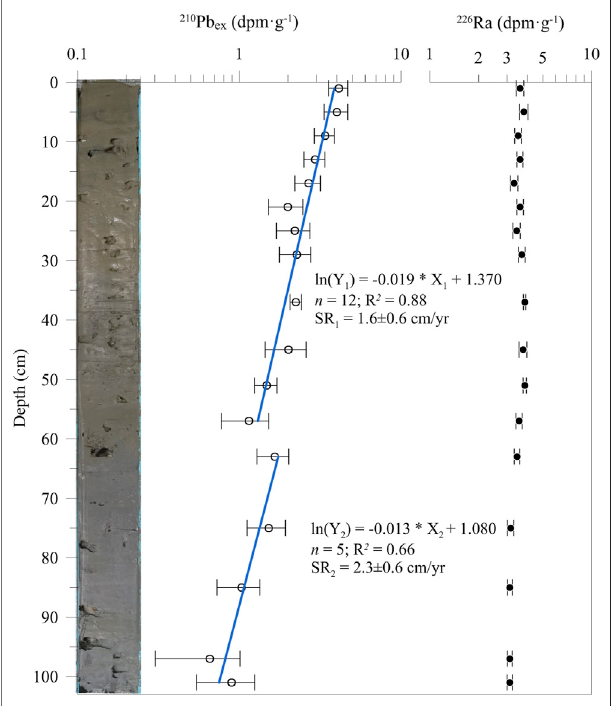
FIGURE 2 | Vertical distribution of 210 Pb ex and 226 Ra and a photograph ofsedimentcoreSKL8-2.Deptherrorsare ± 1cm.Thebluelinesrepresentthe linear fi tting results with the detailed information on the